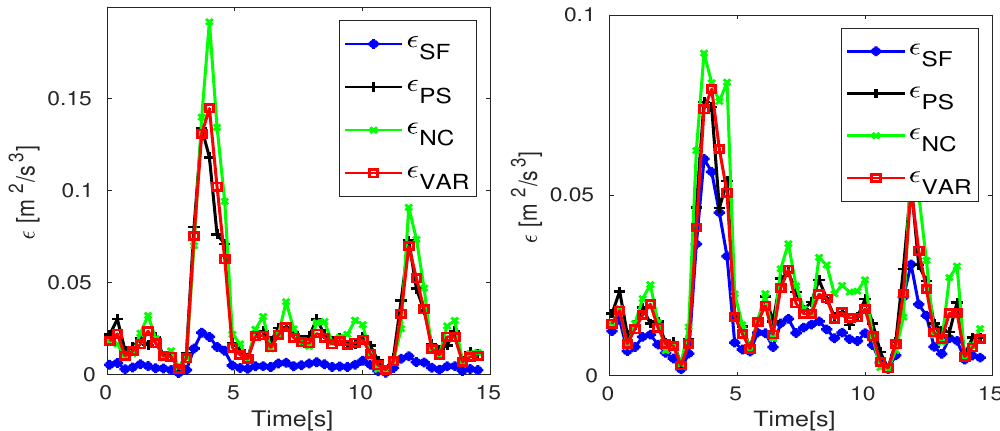
Figure 29. EDR estimates for signals measured during POST flight 3 [15] with f s = 10 Hz. Left panel : fitting range f = [ 0.5 ÷ 3.5 ] Hz and f cut = 3.5 Hz, right panel : fitting range corresponding to f = [ 2 ÷ 5 ] Hz for (cid:101) SF and f = [ 0.5 ÷ 2.5 ] Hz for (cid:101) PS and (cid:101) NCF , f cut = 2.5 Hz for (cid:101) VAR